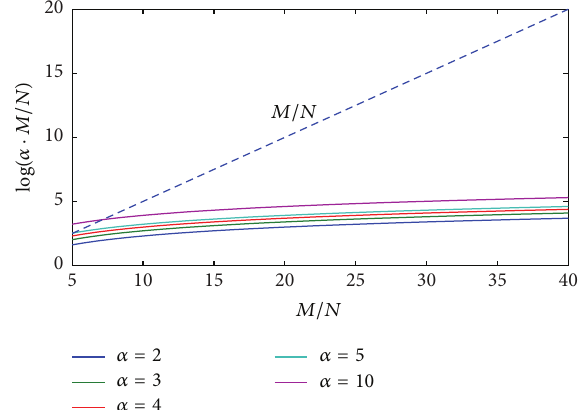
Figure 1: Behavior of (18) for the case 𝑁 = 2 , 𝛼 = 2,3,4,5,10 : ratio 𝑀/𝑁 is required to be between 7 and